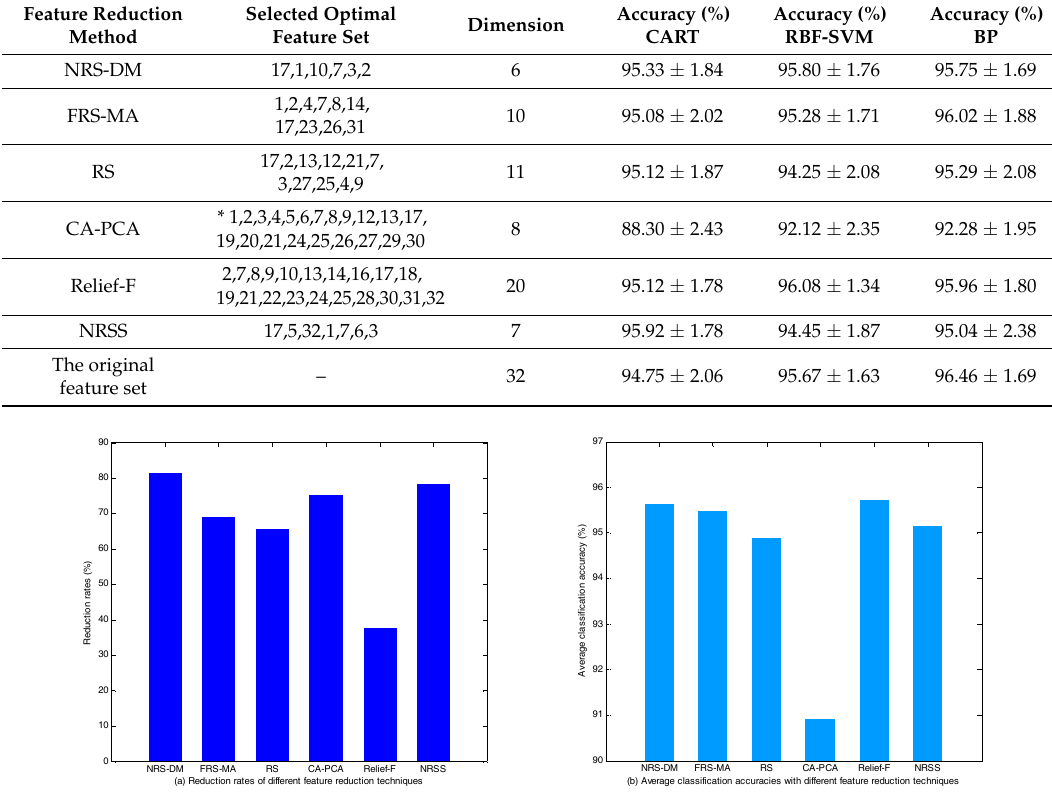
Figure 6. Performance comparison of different feature reduction methods (NES39).